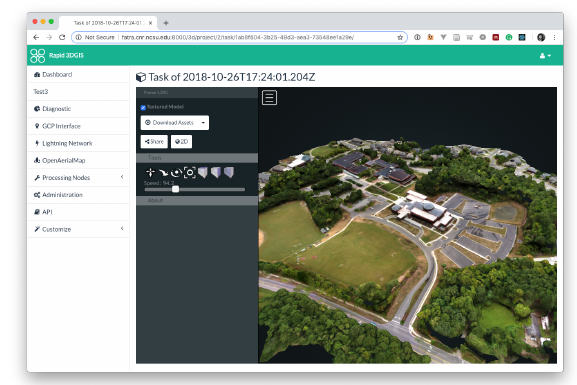
Figure 5: Generated orthoimagery and 3D model using structure